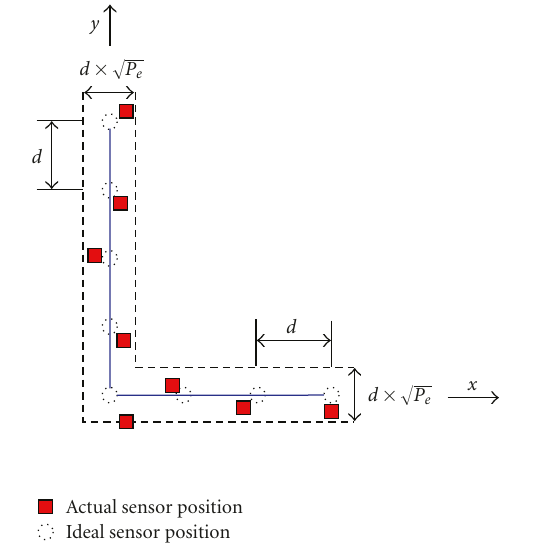
Figure 3: An array with sensor position errors.